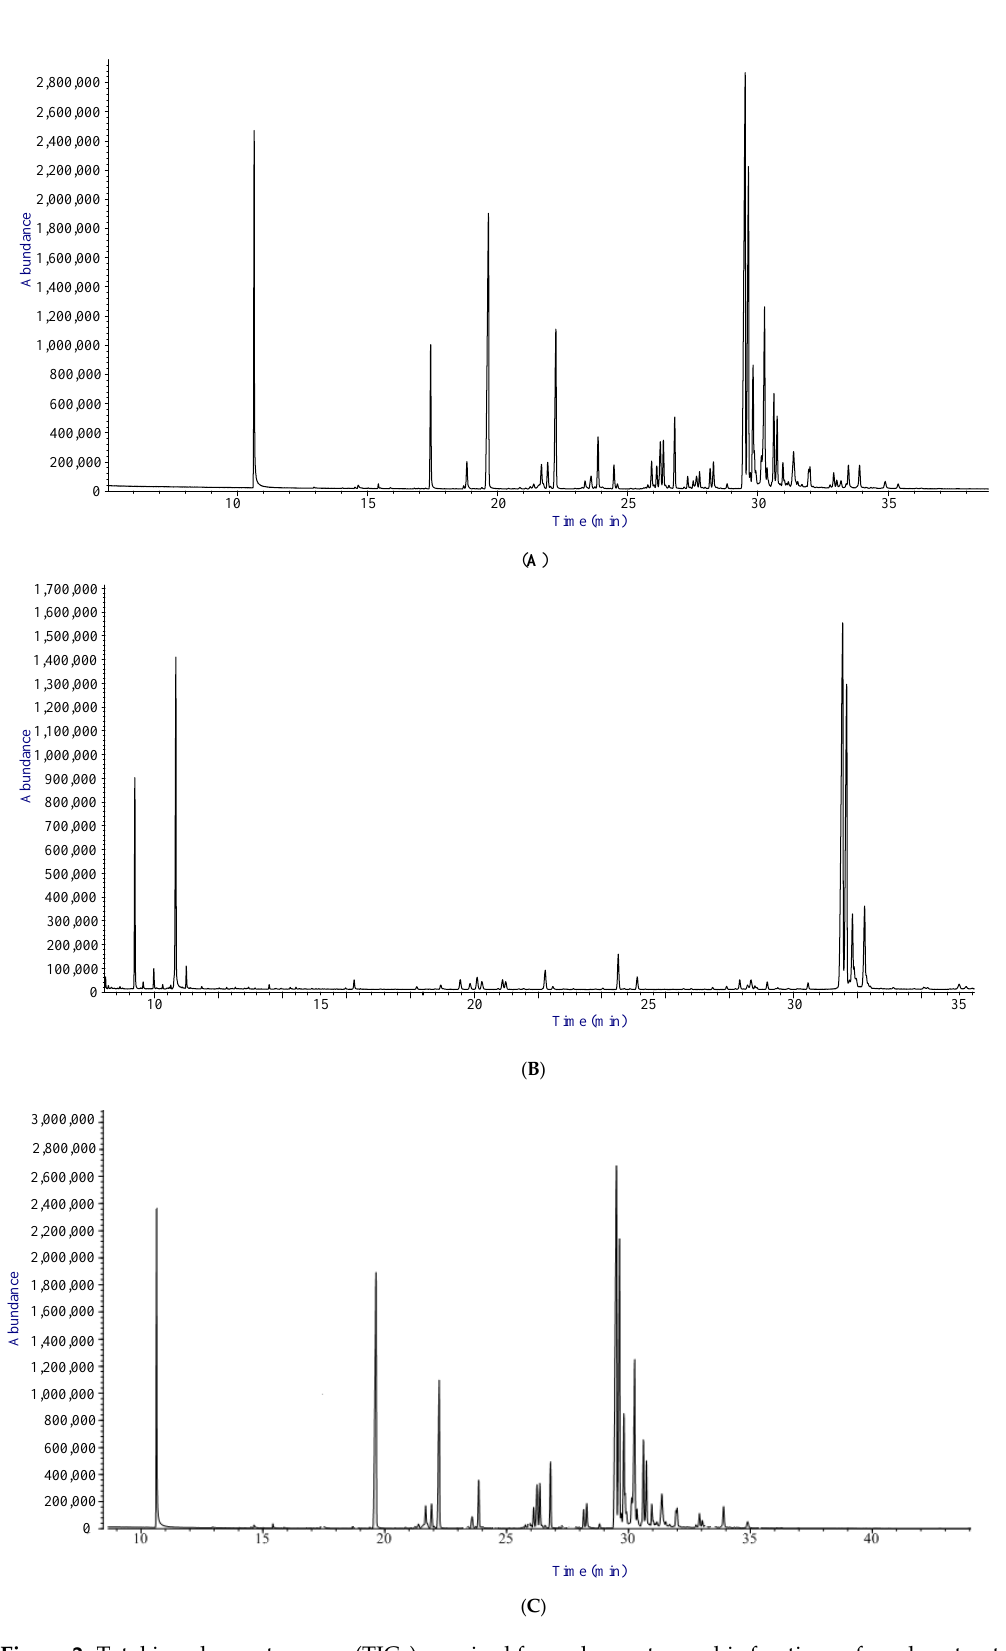
Figure 2. Total ion chromatograms (TICs) acquired from chromatographic fractions of crude extract obtained from P. lividus shells: fraction A ( A ); fraction C ( B ), and fraction D ( C